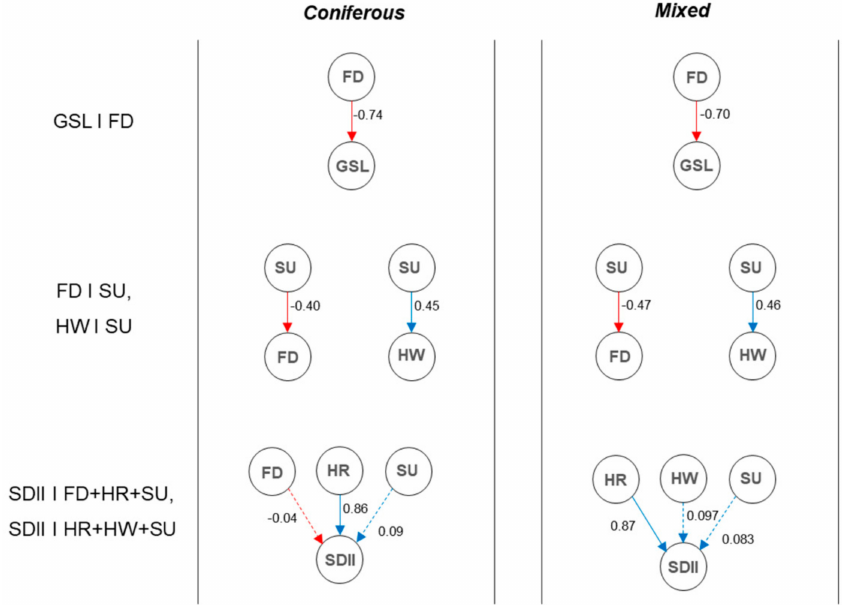
Figure 6. Causality among climate extremes for coniferous and mixed forests. The figure indicates the underlying causal relationships among climate extremes. Numeric values indicate the degree of conditional density. The red color indicates negative causality and the blue color indicates positive causality between two nodes. The solid line reflects a strong relationship (conditional density > 0.25), and the dotted line reflects a weak relationship (conditional density ≤ 0.25): GSL: Growing season length; FD: Frost days; SU: Summer days; HW: Heat wave days; SDII: Simple daily precipitation intensity; HR: Precipitation over 80